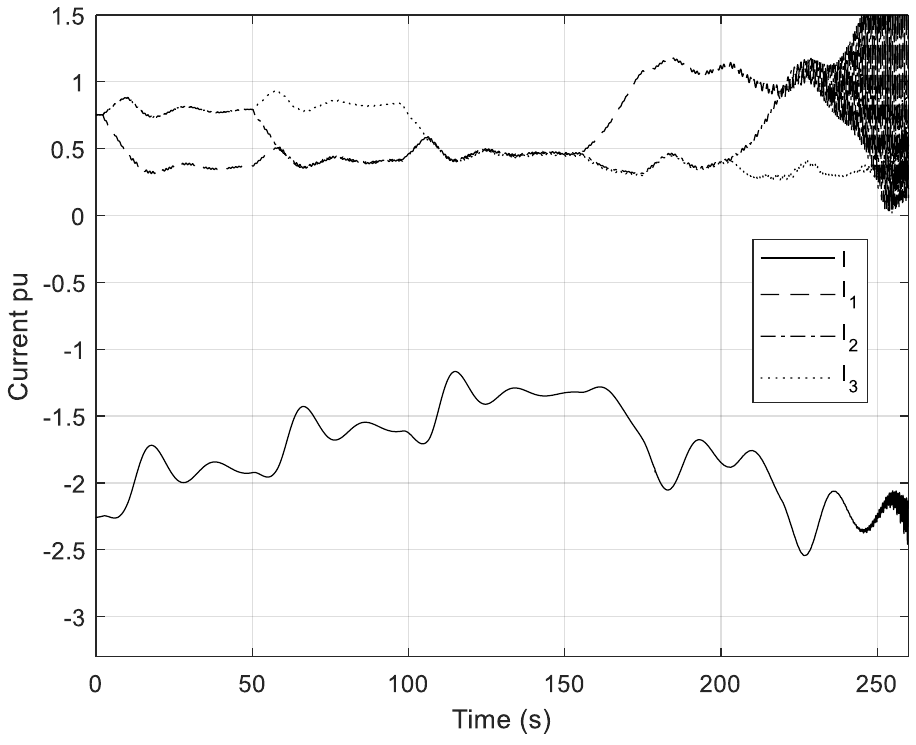
Figure 11. Currents of the B2B converter and WGs for control system with disabled P pitch controller.